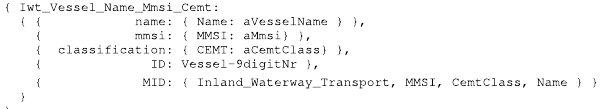
Frontiers in Robotics and AI |